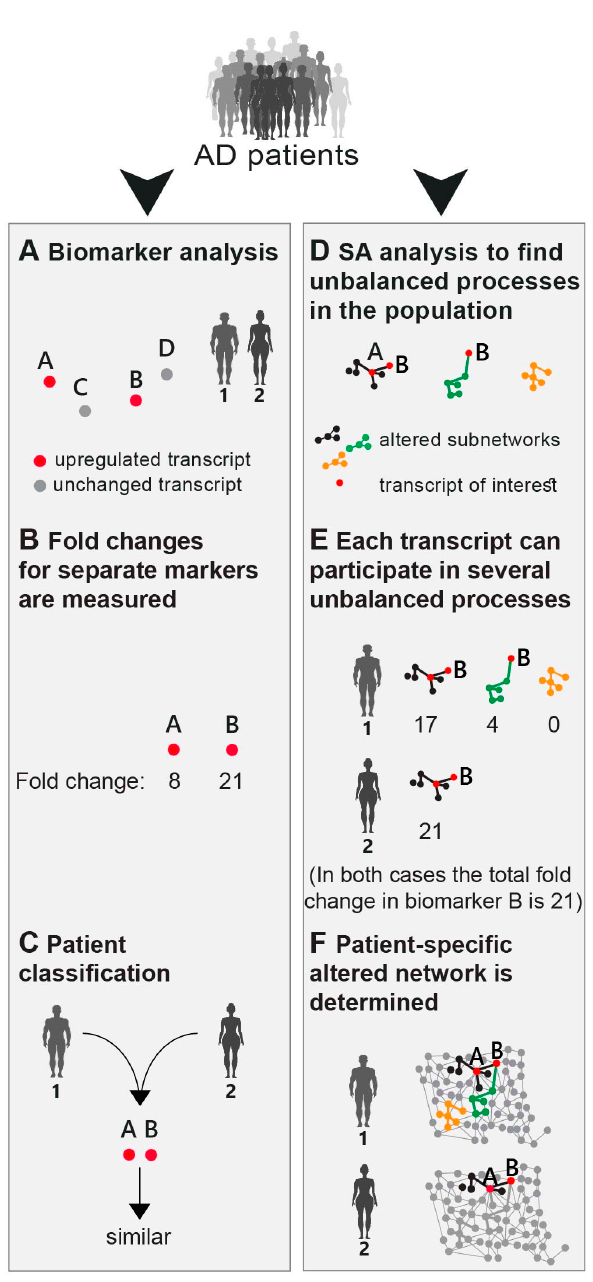
Figure 1. An overview of the approach. ( A ) The common strategy today is to look for novel biomarkers that would classify Alzheimer’s disease (AD) patients in a more accurate, patient-specific manner. In the illustrated example, four AD biomarkers were tested (genes A–D ). Based on the expression levels of those markers ( B ) the patients are classified. Patients 1 and 2 in this example have similar expression levels of biomarkers A and B, and therefore would be classified as molecularly similar ( C ). We explore AD pathology in an unbiased manner ( D – F ). The workflow of our approach consists of patient-specific “omic” profiling, followed by surprisal analysis ( D ), aiming to decipher not only altered transcripts / proteins, but also the structure of the altered network, namely the patient-specific altered transcriptional signature ( E , F ). This signature is composed of distinct unbalanced processes, each resulting from a constraint that operates on the system (see main text). Overexpression of the biomarker B in patient 1 is associated with the black and green processes, whereas in patient 2 it is upregulated due to only the black process ( D – F ).